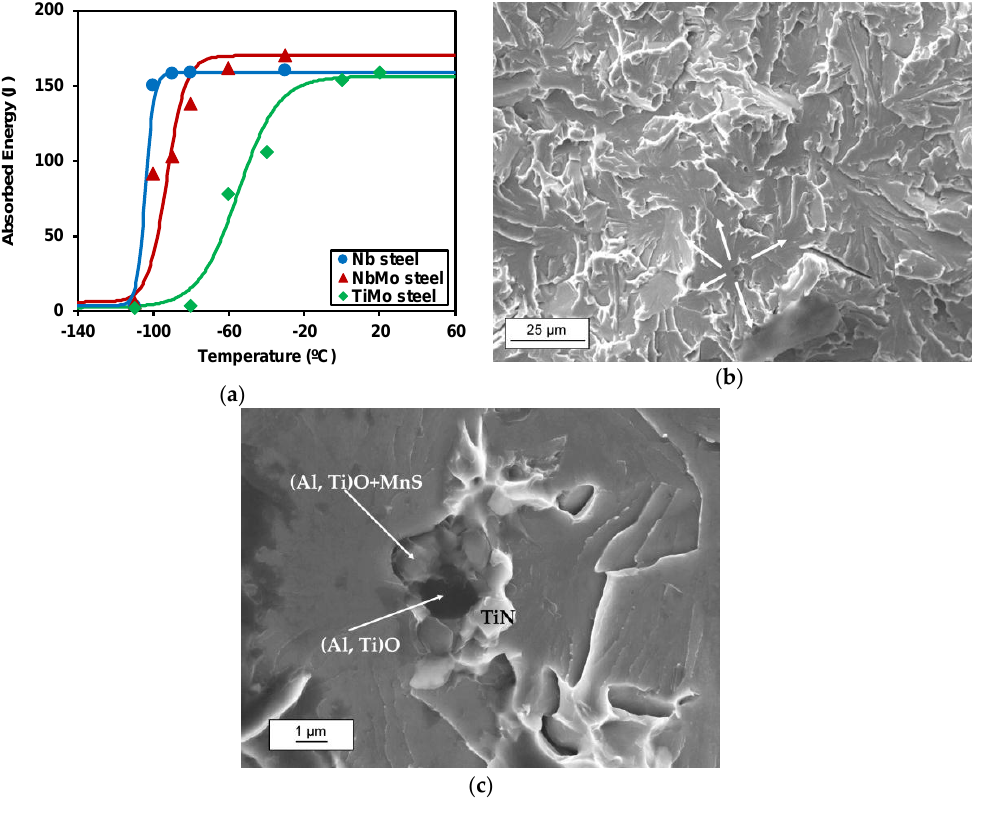
Figure 9. ( a ) Absorbed energy as a function of test temperature with a coiling temperature of 700 °C. ( b , c ) Fracture images corresponding to the TiMo steel and a coiling temperature of 700 °C, showing the origin of the brittle fracture.